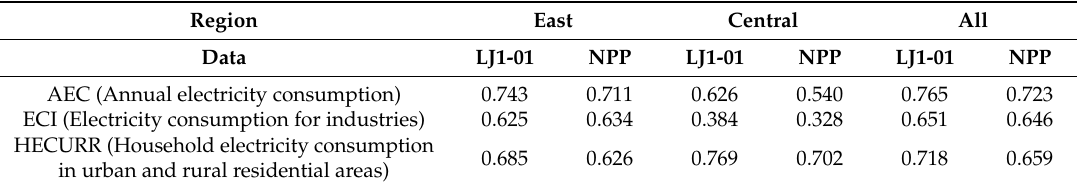
Table 6. Linear regression R 2 values for electricity consumption and